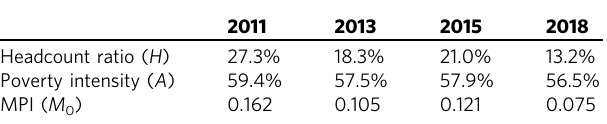
Table 3 Multidimensional poverty measures from 2011 to 2018.